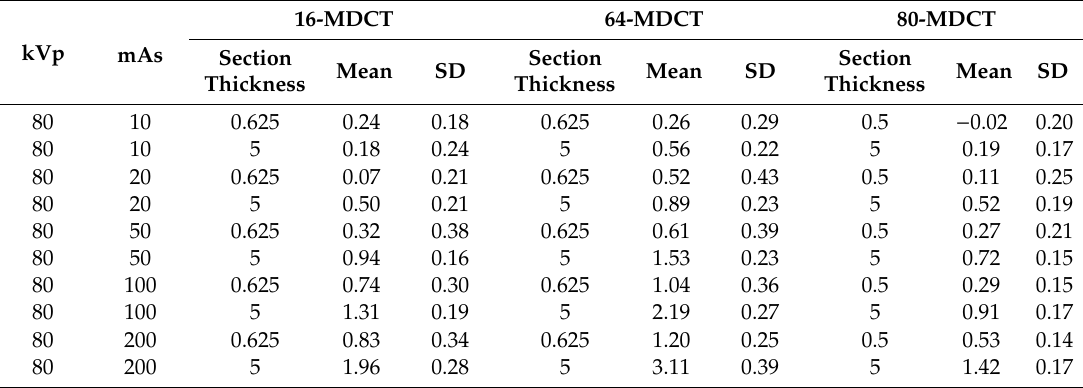
Figure 2. Limited effects of the size of 1% contrast levels objects on CNR values for all CT scanners. (Note the change in CNR values for 16-MDCT with 8-mm object size and for 80-MDCT with 5-mm object size.) Table 3. Mean CNR values of the images at 80 kVp. The mean values were obtained by averaging three identical exposures.